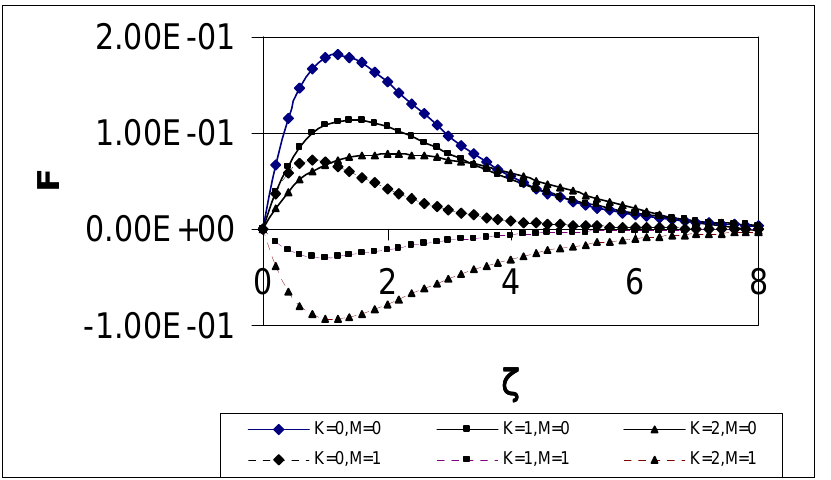
Fig. 4. Effect of the porosity parameter M and the non-Newtonian parameter K on the profile of F.